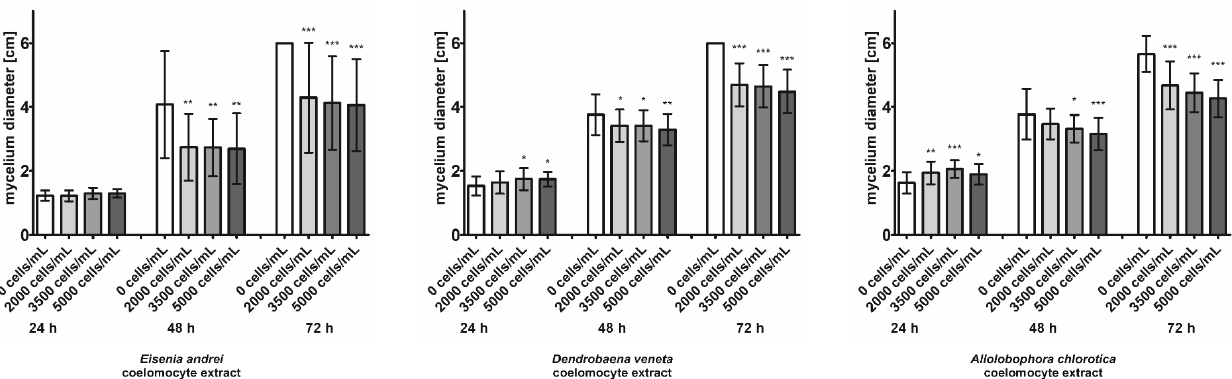
Figure 2. Growth (mean diameter ± SD) of Fusarium culmorum mycelium 24, 48 and 72 h after treatment with Eisenia andrei , Dendrobaena veneta and Allolobophora chlorotica coelomic fluid extracts. Significant differences between control and groups treated with coelomocyte extracts are labeled with * ( p < 0.05), ** ( p < 0.01) and *** ( p <